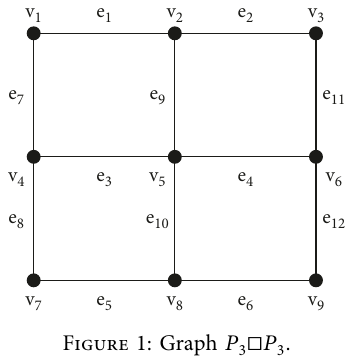
Figure 1: Graph P